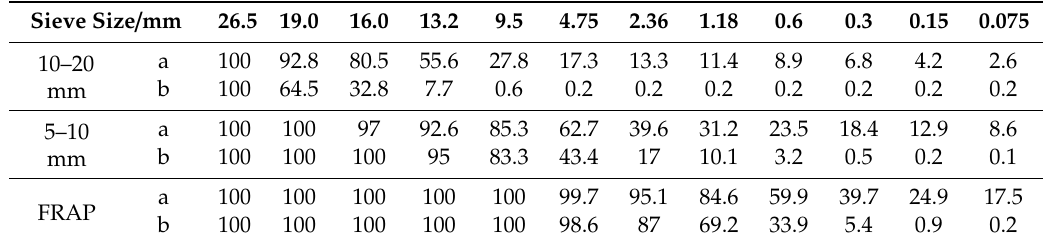
Table 1. The gradations of reclaimed asphalt pavement (RAP).